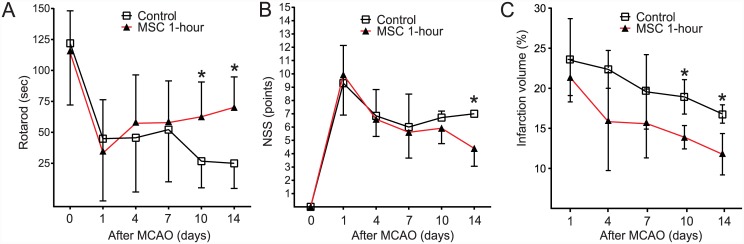
Neurological Recovery and Infarction Volume.The surviving animals (MSC 1-hour group, n = 32; control group, n = 27) were subjected to behavioral tests by using the rotarod test and by measuring the modified Neurologic Severity Score (NSS) at baseline and at 1, 4, 7, 10, and 14 days after MCAO. In the rotarod test, the MSC 1-hour group exhibited statistically significant functional recovery at 10 and 14 days (A). The modified NSS at 14 days also revealed greater recovery in the MCS 1-hour group than in the control group. Because the modified NSS scores at 14 days of all 4 rats in control group were 7, the error bar could not be drawn (B). The infarction volume was smaller in the MSC 1-hour group than in the control group at 10 and 14 days after MCAO (C).